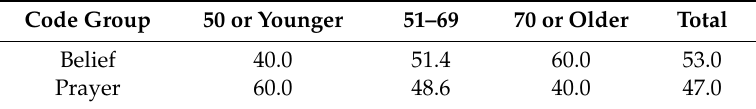
Table 14. Problems of ritual transfer—personal context—age.